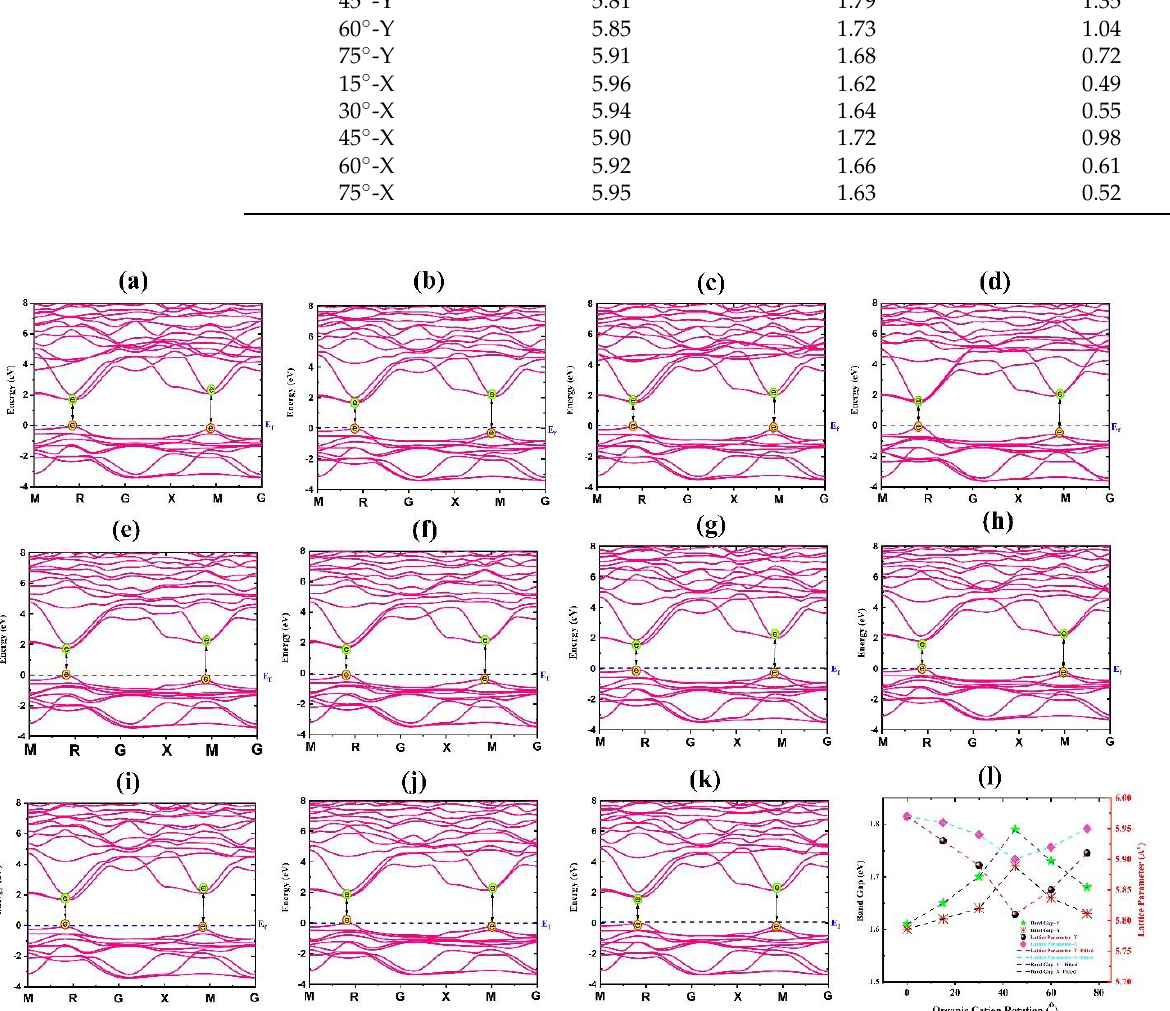
Figure 2. Calculated band structure of FAPbBr 3 perovskite without SOC for rotational modes of ( a ) 0 ◦ -X, ( b ) 15 ◦ -Y, ( c ) 30 ◦ -Y ( d ) 45 ◦ -Y, ( e ) 60 ◦ -Y, ( f ) 75 ◦ -Y, ( g ) 15 ◦ -X, ( h ) 30 ◦ -X, ( i ) 45 ◦ -X, ( j ) 60 ◦ -X and ( k ) 75 ◦ -X. ( l ) Variations of bandgap and lattice parameter in term of rotational orientation.